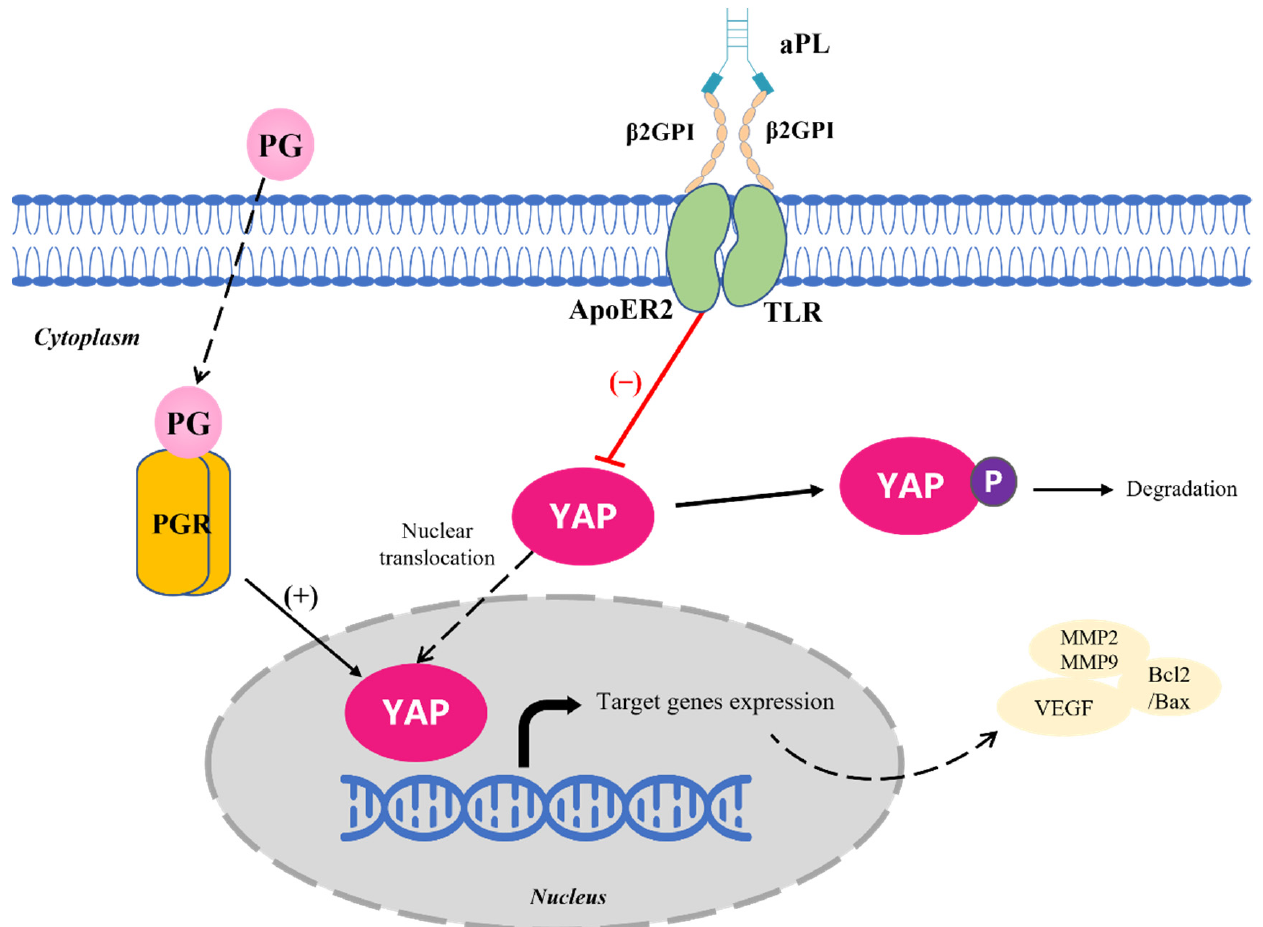
Figure 7. Schematic diagram of the hypothesized molecular mechanism for YAP protein